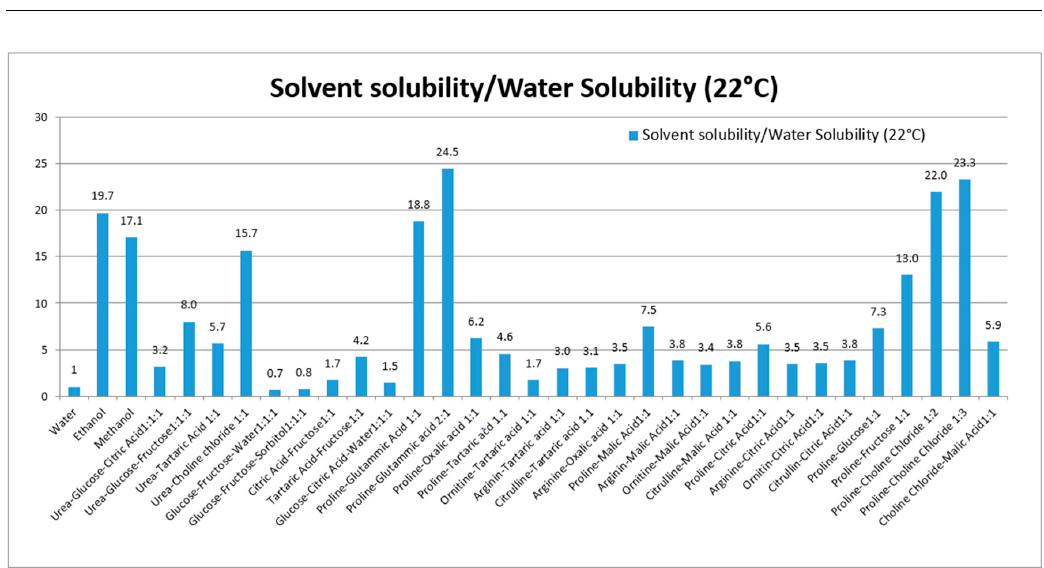
Figure 1. Solubility ratio of rutin (solvent/water) in each prepared NADES. The solubility in all solvents were significantly different from solubility in water ( p -values < 0.05).